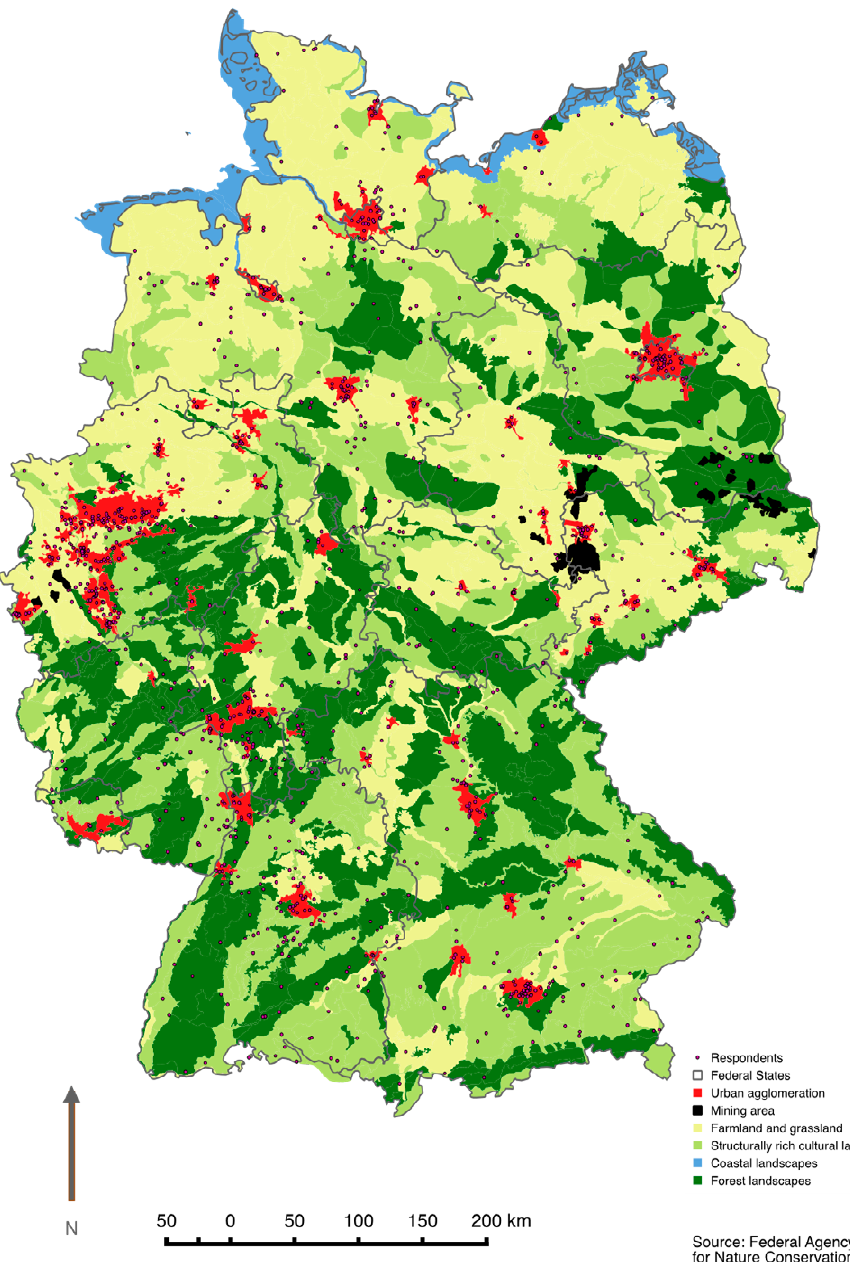
Figure 2. Spatial distribution of